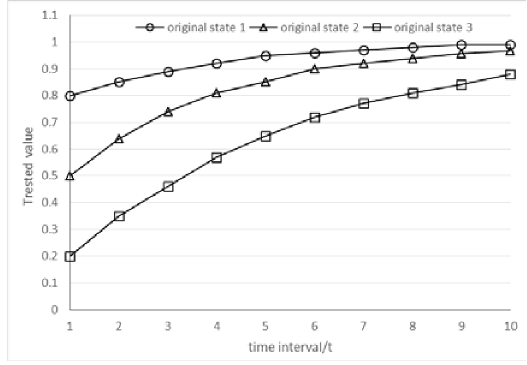
Fig. 3. The trusted value curves under different initial conditions.